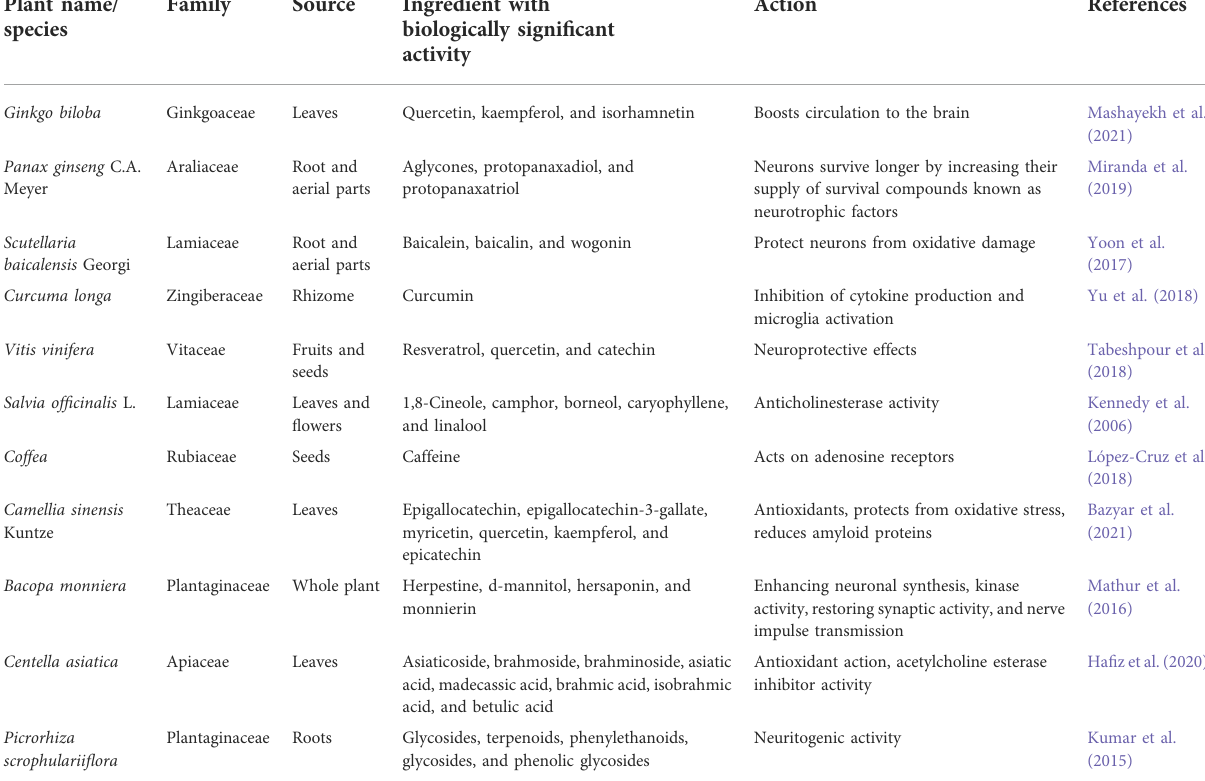
TABLE 1 Different types of plants along with their biological